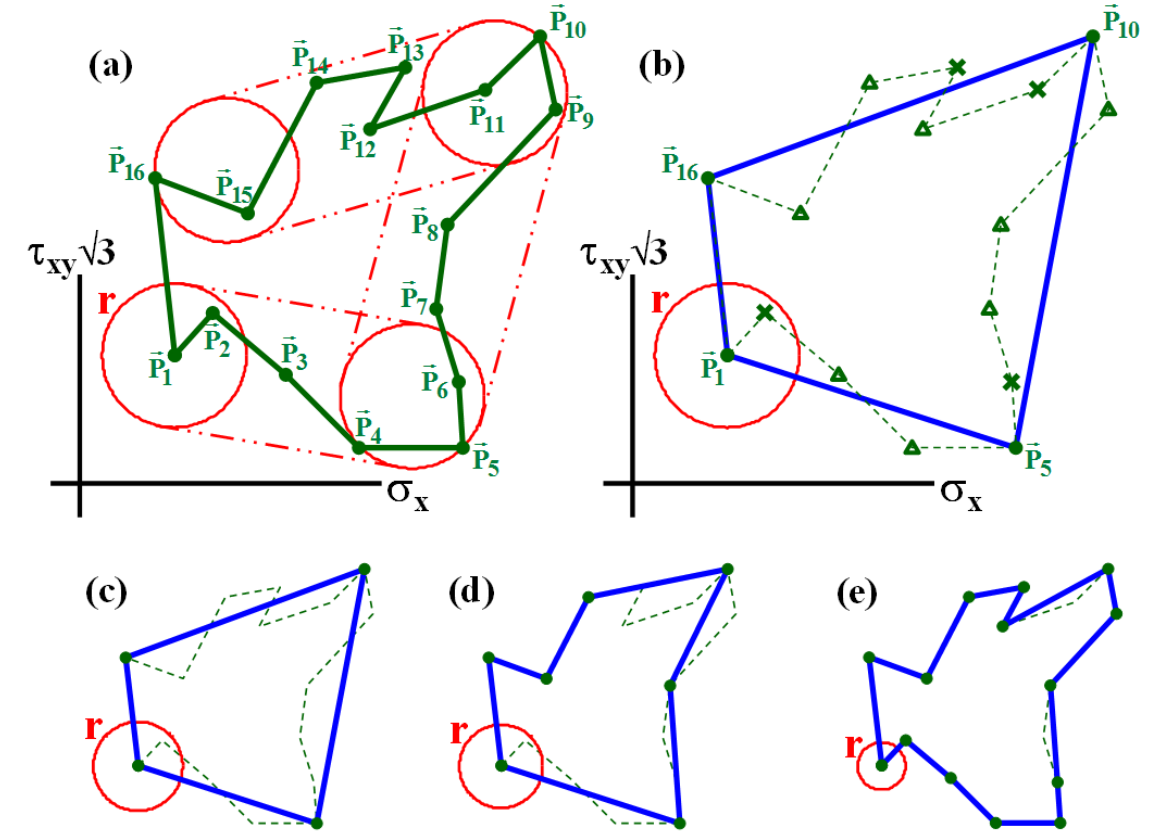
Figure 7: Multiaxial racetrack filter applied to a tension-torsion history path with 16 points, showing (a) the translating hyper-spheres, (b) the static and dynamically-filtered points (respectively × and triangles), and the effect of decreasing the filter amplitude r , resulting in histories with (c) four, (d) seven, and (e) fourteen